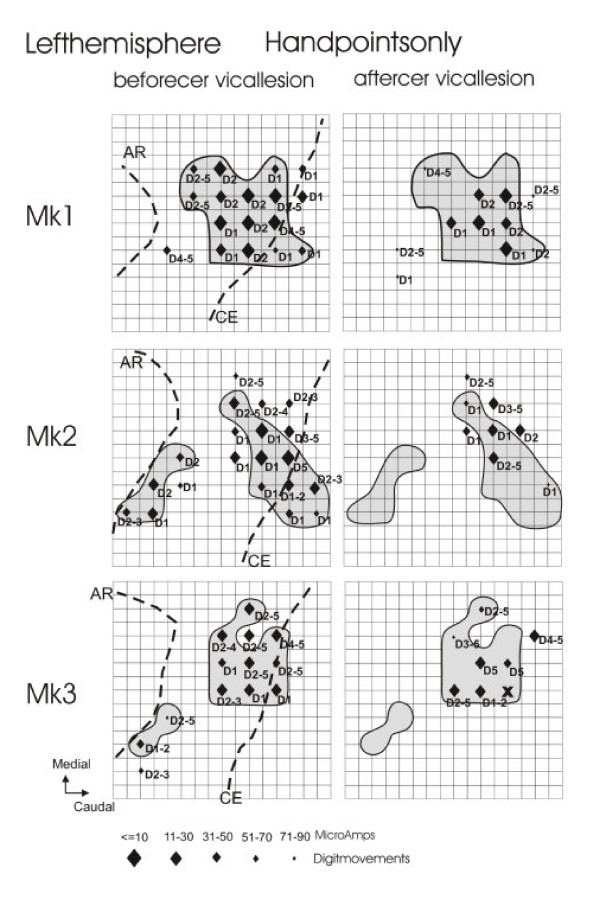
Hand representation in the ipsilesional motor cortex. Somatotopic map in the ipsilesional hemisphere as in Fig. 3, but represented are only the electrode penetrations in which digit movements were observed. The gray zones correspond to the hand areas as defined in Figure 3. Outside these areas, other electrode tracks are represented, along which ICMS produced digit movements, but at an intensity that was higher than effects observed for other body territories. Same conventions as in Figure 3.